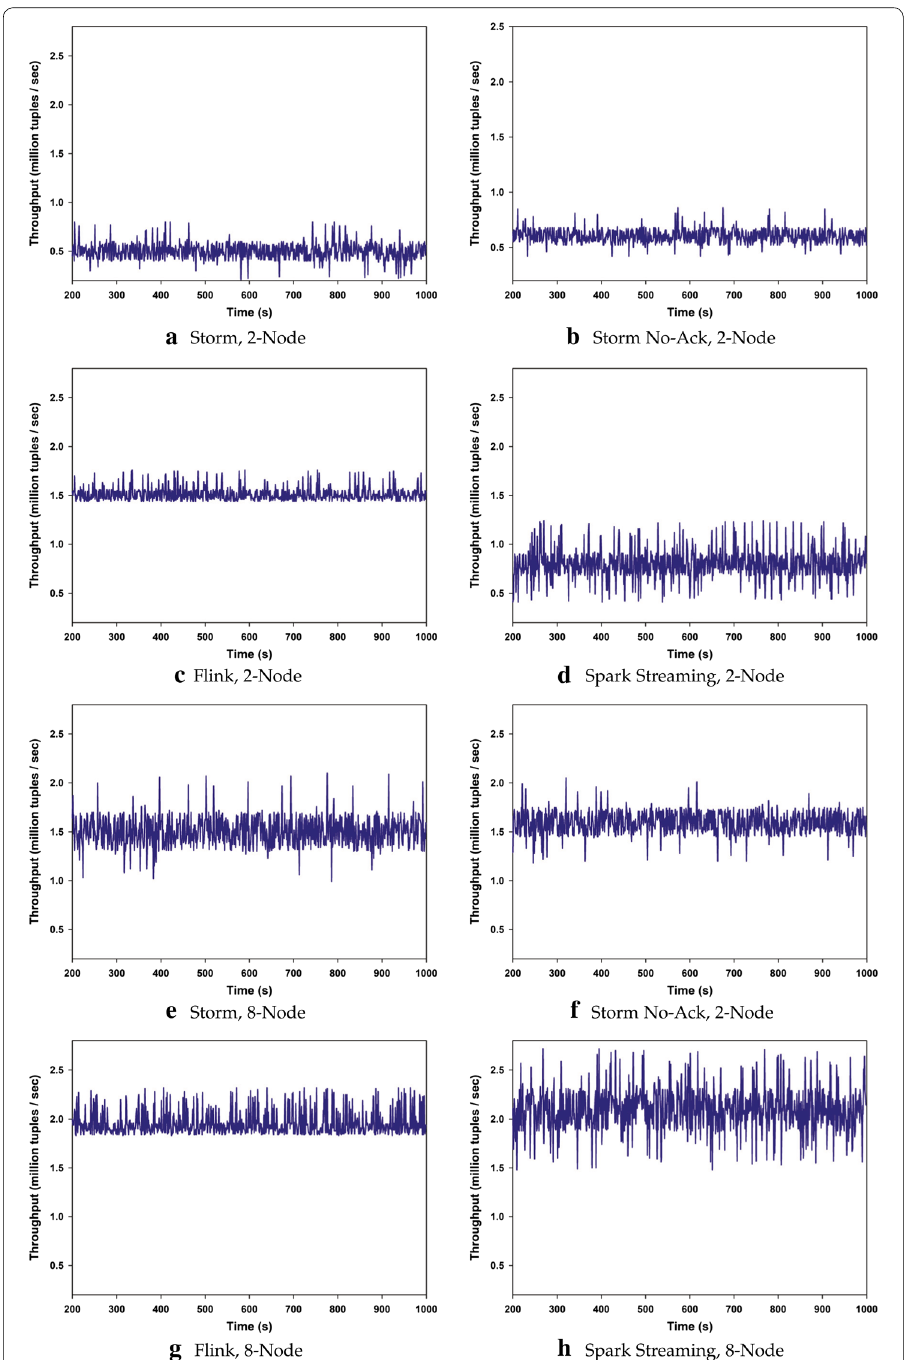
Fig. 13 Throughput of intended frameworks with different number of worker nodes for Advertising